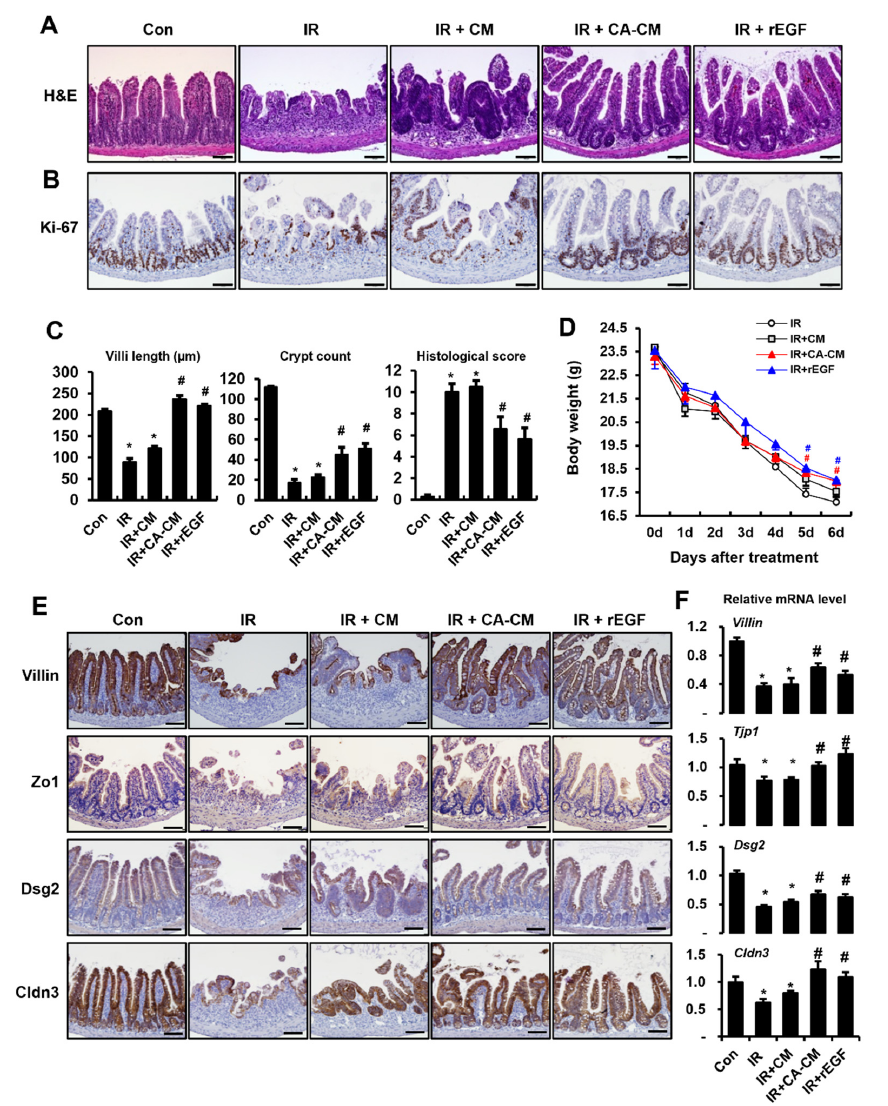
Figure 7. Centella asiatica -derived endothelial epidermal growth factor mitigates radiation-induced enteritis with epithelial barrier restoration in mouse model. Mouse groups are as follows: control (Con), irradiated (IR), irradiated mouse administrated with the conditioned media (CM) of irradiated HUVECs (IR + CM), CM of Centella asiatica (CA)-treated irradiated HUVECs (IR + CA-CM), and recombinant EGF (IR + rEGF). ( A ) Hematoxylin and eosin staining of mouse intestinal tissue sections was performed in each group. ( B ) Proliferation was assessed by staining intestinal sections with ki-67. ( C ) The lengths of villi and crypts in the intestinal sections were quantified. Histological scoring was assessed based on the degree of epithelial architecture maintenance, crypt disruption, vascular enlargement, and infiltration of inflammatory cells in the lamina propria of the ileum of Con, IR, IR + CM, IR + CA-CM, and IR + rEGF groups (0 = none, 1 = mild, 2 = moderate, and 3 = high). ( D ) Body weights of Con, IR, IR + CM, IR + CA-CM, and IR + rEGF groups were determined. ( E ) Immunohistochemistry against epithelial barrier-related molecules, e.g., villin, zonula occuludens 1 (Zo1), desmoglein 2 (Dsg2), and claudin 3 (Cldn3), in the Con, IR, IR + CM, IR + CA-CM, and IR + rEGF groups was performed. ( F ) mRNA levels of the epithelial barrier-related molecules in Con, IR, IR + CM, IR + CA-CM, and IR + rEGF groups were assessed by qRT-PCR. Data are presented as the mean ± standard error of the mean; n = 6 mice per group. * p < 0.05 compared to the Con group; # p < 0.05 compared to the IR group. Scale bars represent 100 µ m. All data represent at least two independent